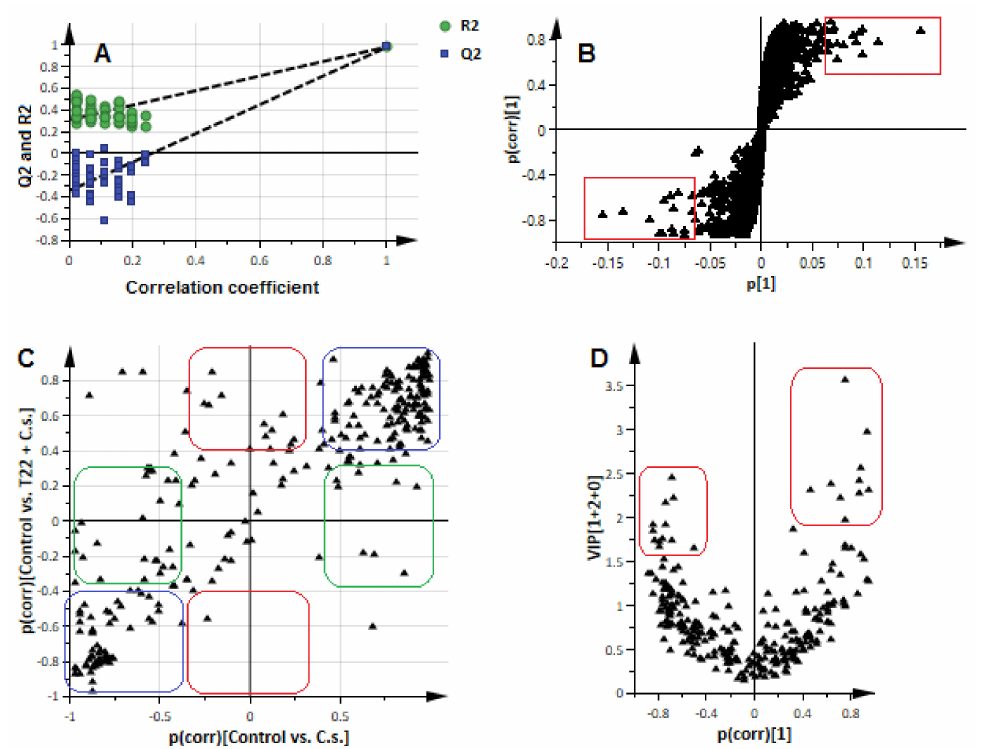
Figure 3. OPLS-DA modelling and variable (statistically significant discriminatory features / biomarkers) selection. ( A ): A typical response permutation test plot ( n = 50) for the OPLS-DA model of the ESI(-) data, separating ‘control vs. challenged primed-plants’ at 5–9 d.p.i. (1 + 2 + 0 components, R 2 X = 0.658, Q 2 = 0.978, CV-ANOVA p -value = 0.00); the R 2 and Q 2 values of the permutated models correspond to y -axis intercepts: R 2 = (0.0, 0.308) and Q 2 = (0.0, − 0.347). ( B ): An OPLS-DA loadings S-plot for the same model in ( A ); variables situated far out in the S-plot are statistically relevant and represent prime candidate discriminating variables. The red boxes indicate the selected ions—as discriminating variables, with high covariation and correlation. ( C ): A Shared and Unique Structures (SUS) analysis: a SUS-plot comparing the metabolite features contributing to the model separating ‘control vs. challenged naïve plants’ (control vs. C.s ., ESI(-) data, x -axis; 1 + 1 + 0 components; R 2 X = 0.704, Q 2 = 0.993, CV-ANOVA p -value = 0.00) with that of the model separating ‘control vs. challenged primed plants’ (control vs. P. alvei (T22) + C.s ., ESI(-) data, y -axis; 1 + 2 + 0 components, R 2 X = 0.658, Q 2 = 0.978, CV-ANOVA p -value = 0.00). Blue boxes represent shared features, green boxes represent features linked with the response of naïve plants to the fungal infection and red boxes the unique features due to the combination of priming and fungal infection. ( D ): A V-like shaped plot (Plot / List Plot) displaying the combination of variable importance in projection (VIP) scores and p(corr) values for the variables in S-plot in ( B